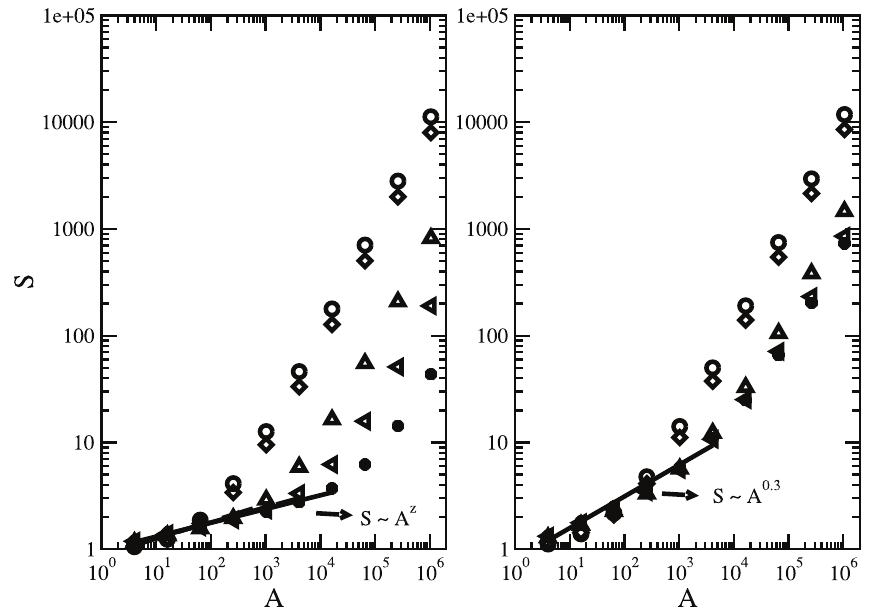
Figure 2. Effect of H on biodiversity levels. Species-area relationships for different values of the Hurst exponent H and fixed fraction of suitable habitats p ~ 0 : 6 . The parameter values are L ~ 1024 ; Hurst exponent: H ~ 0 (circles), H ~ 0 : 1 (diamonds), H ~ 0 : 5 (triangles up), H ~ 0 : 7 (triangles left) and H ~ 0 : 9 (stars); and speciation rate: n ~ 1 | 10 { 6 (left panel) and n ~ 1 | 10 { 4 (right panel). The data points represent an average over 50 independent runs. The error bars are smaller than the symbols.